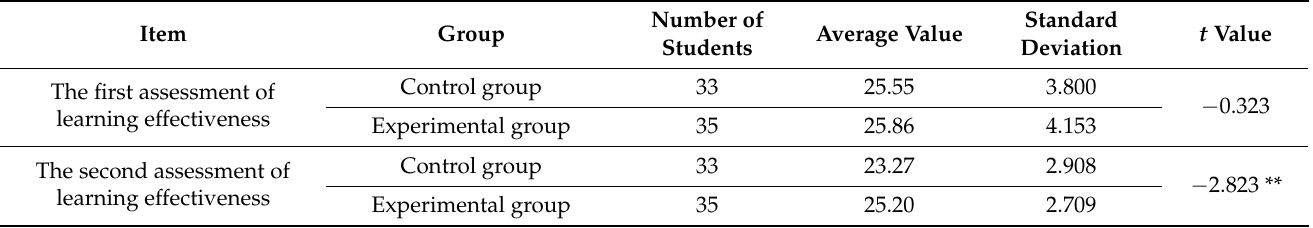
Table 6. Recapitulation sheet of basic electricity practical learning effectiveness scores in terms of